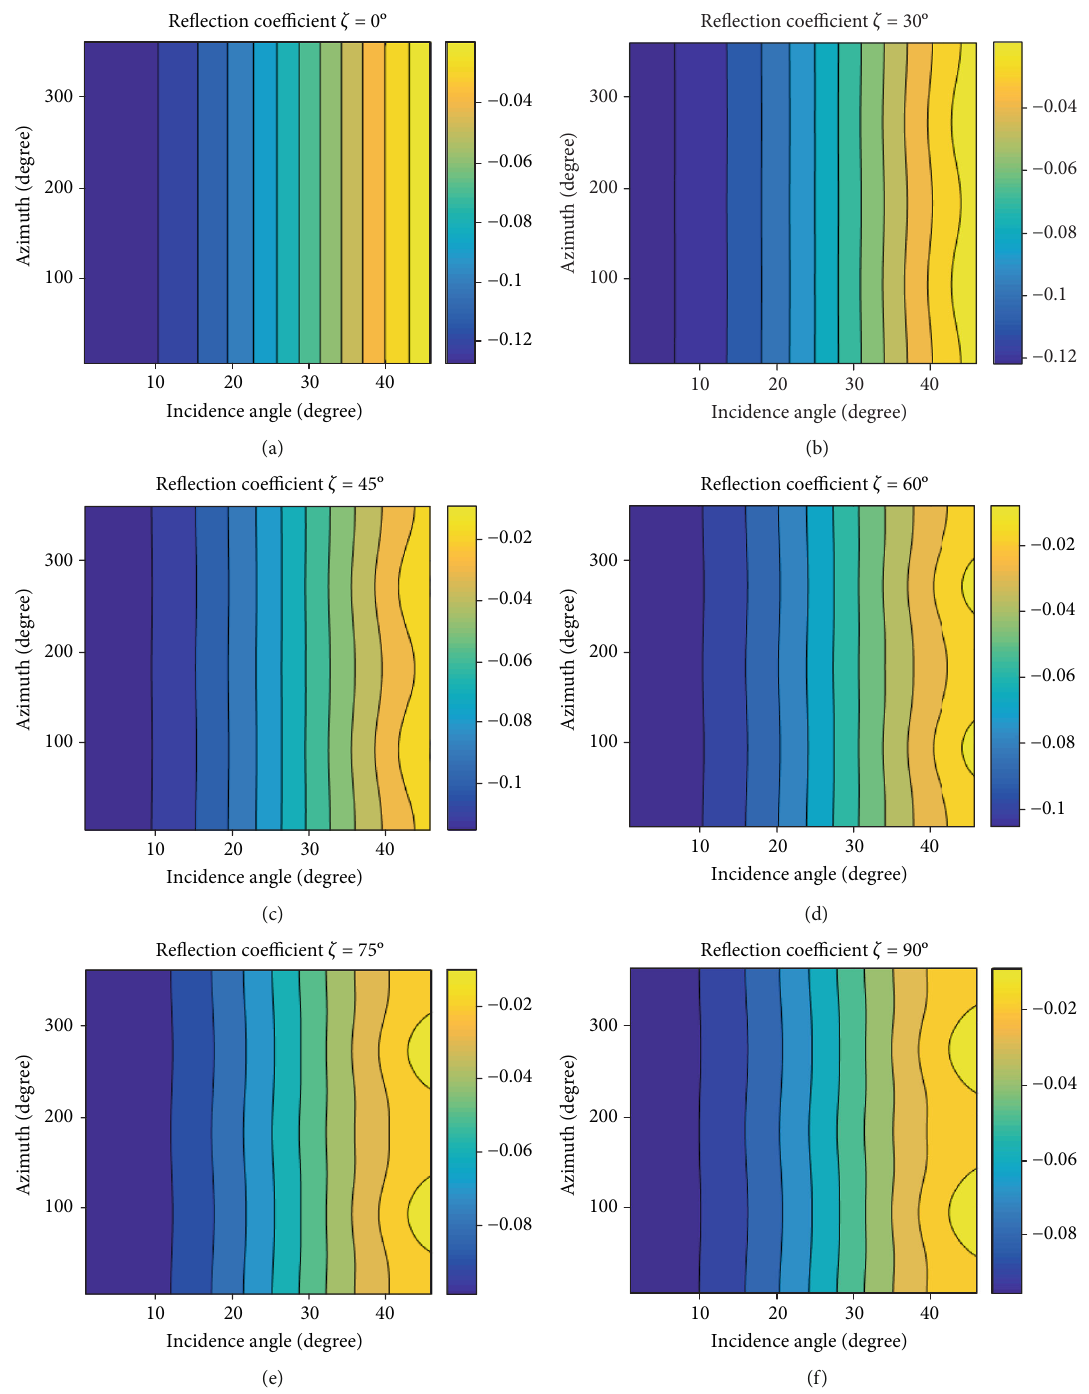
Figure 3: The e ff ect of dip angle of symmetry axis in a TTI medium on the PP-wave re fl ection coe ffi cient. (a) 0 ° (VTI), (b) 30 ° , (c) 45 ° , (d) 60 ° , (e) 75 ° , and (f) 90 °